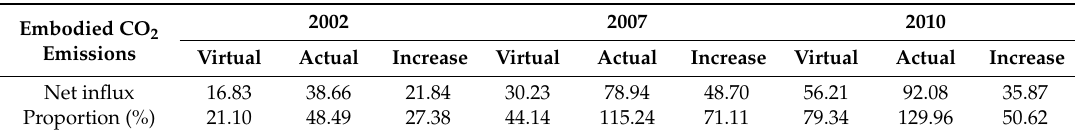
Table 6. Comparison of virtual and actual net embodied CO 2 flowed in Beijing in interprovincial trade (million